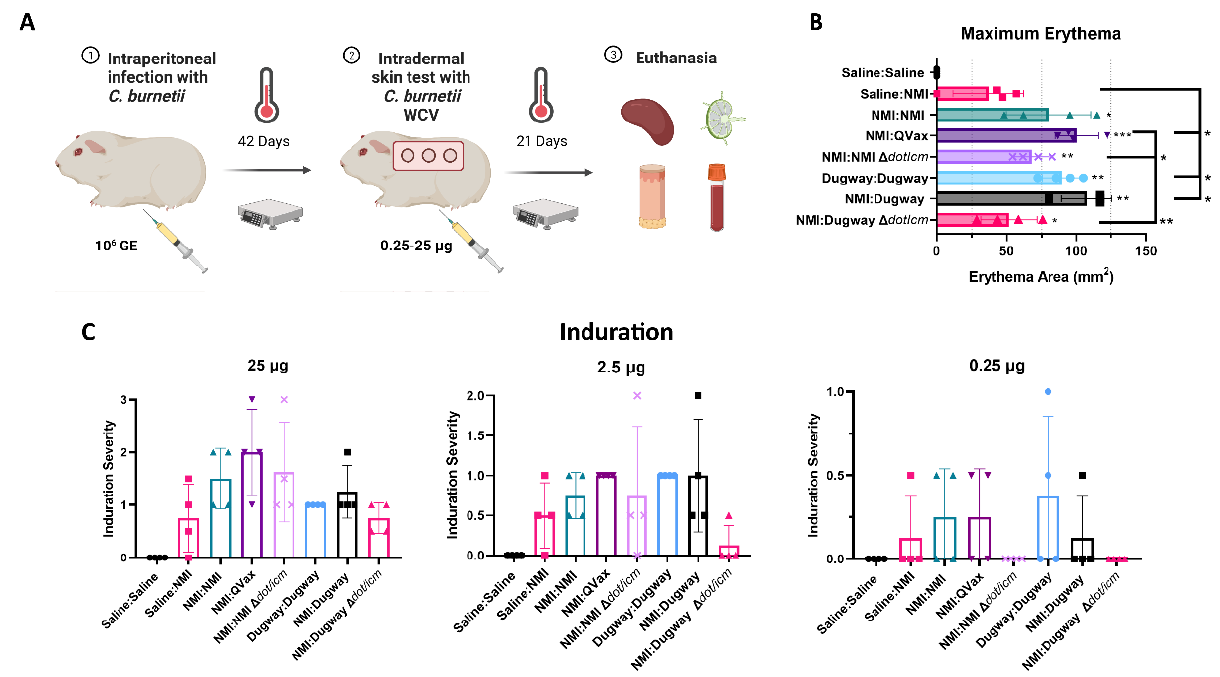
Figure 4. C. burnetii Dugway ∆ dot/icm whole-cell vaccine reduces post-skin testing erythema and late-phase induration magnitude. The guinea pig model of post-vaccination hypersensitivity is outlined in ( A ). Maximum erythema at any given timepoint post-skin testing is depicted in ( B ). Induration scoring values at indicated skin testing site at day 20 post-skin testing ( C ). * p ≤ 0.05; ** p ≤ 0.01; *** p ≤ 0.001.